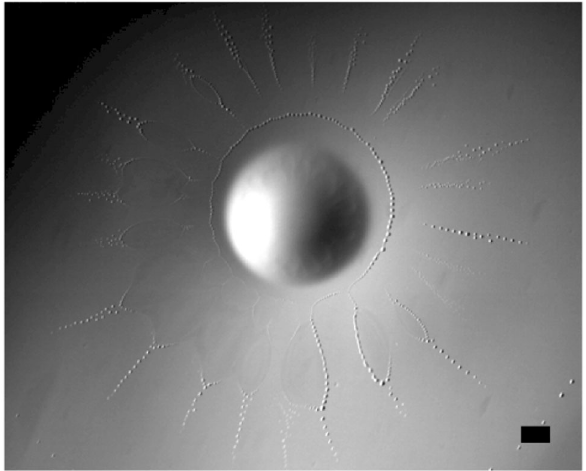
Fig. 6 Islands formed during the late dewetting stage of P 4 . These islands coexist with the advancing rim formed at the beginning of P 5 ; scale bar